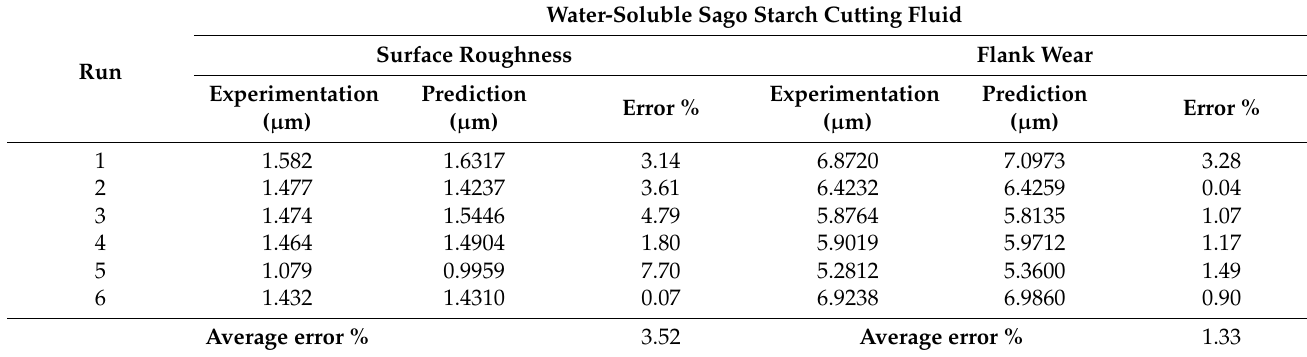
Table 13. Comparison of extreme learning machine (ELM) prediction with experimental findings for water-soluble sago starch cutting fluid.